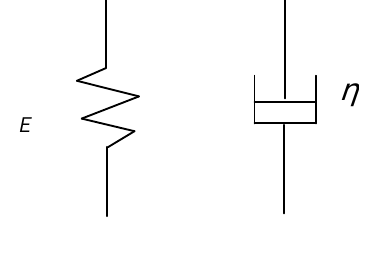
Figure 4. Spring and dashpot